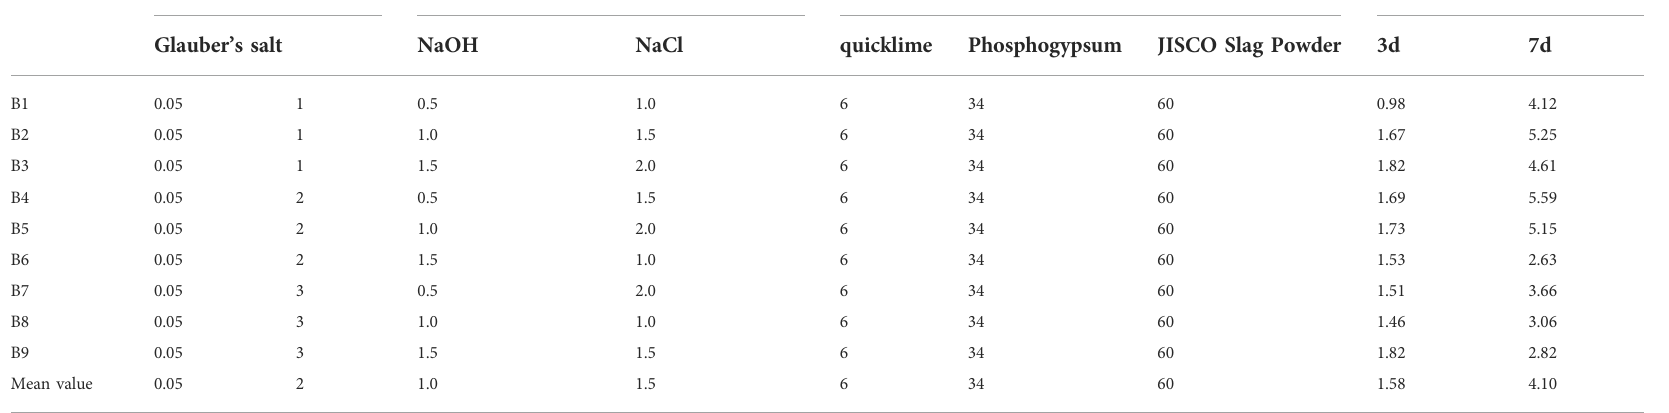
TABLE 4 Orthogonal test results of fi lling body